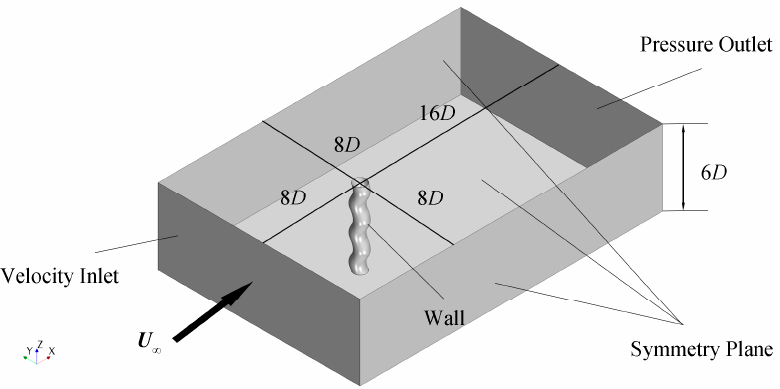
Figure 3. Schematic of the computational domain and boundary conditions.